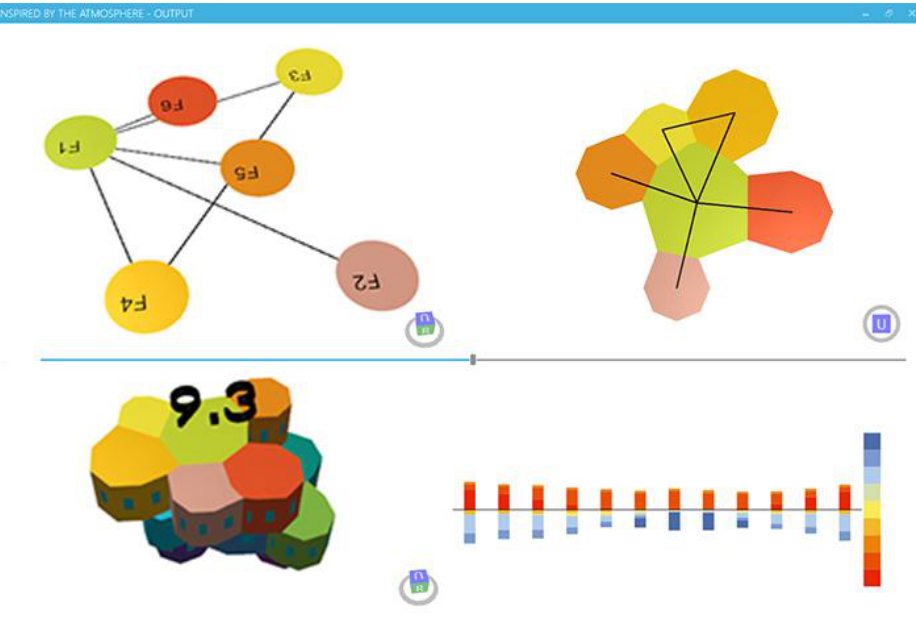
Figure 5. The visual interface: displaying of proposed mutations and Energy